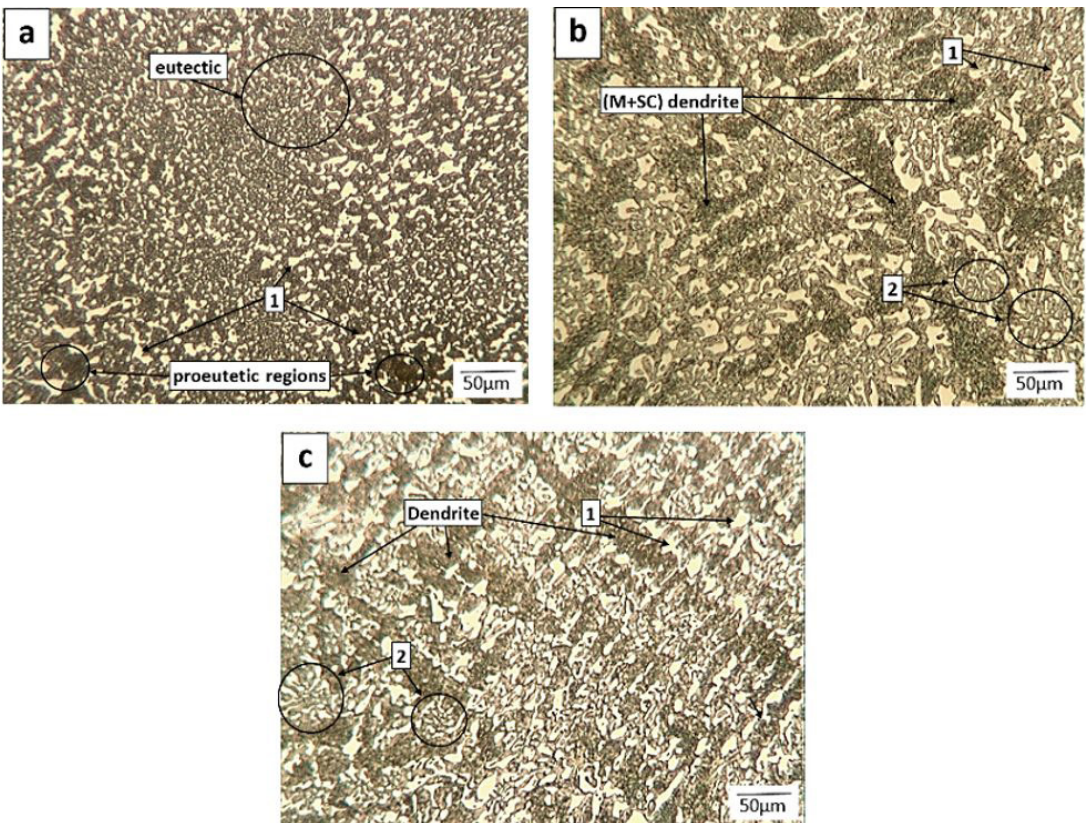
Figure 3. Optical microscopy (a) HCCI0%Nb; (b) HCCI0.5%Nb; (c) HCCI1%Nb. M: Martensite; SC: Secondary Carbides; 1: rods-type M